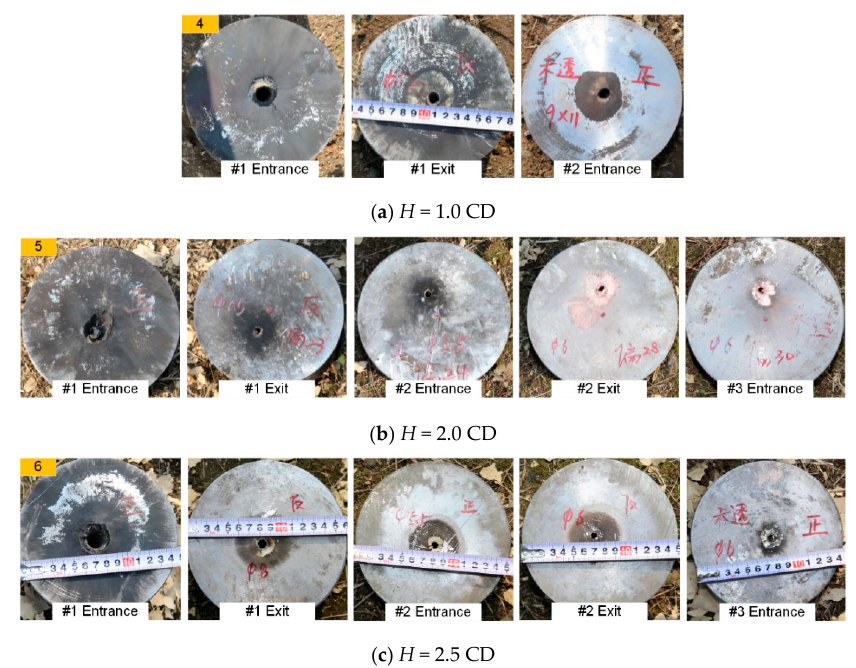
Figure 5. Typical experiments of RM-CL shaped charge with a 3-mm reactive liner.